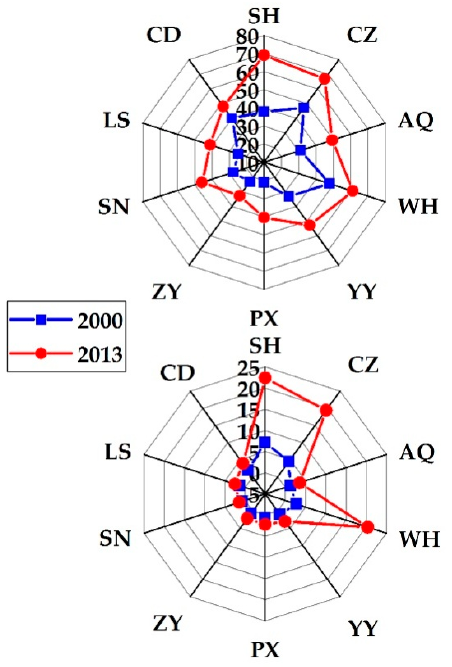
Figure 5. Radar chart of the annual mean near-surface PM 2.5 ( top ) and NO 2 ( bottom ) concentrations at the 10 prefecture-level cities of the YRB in 2000 and 2013.